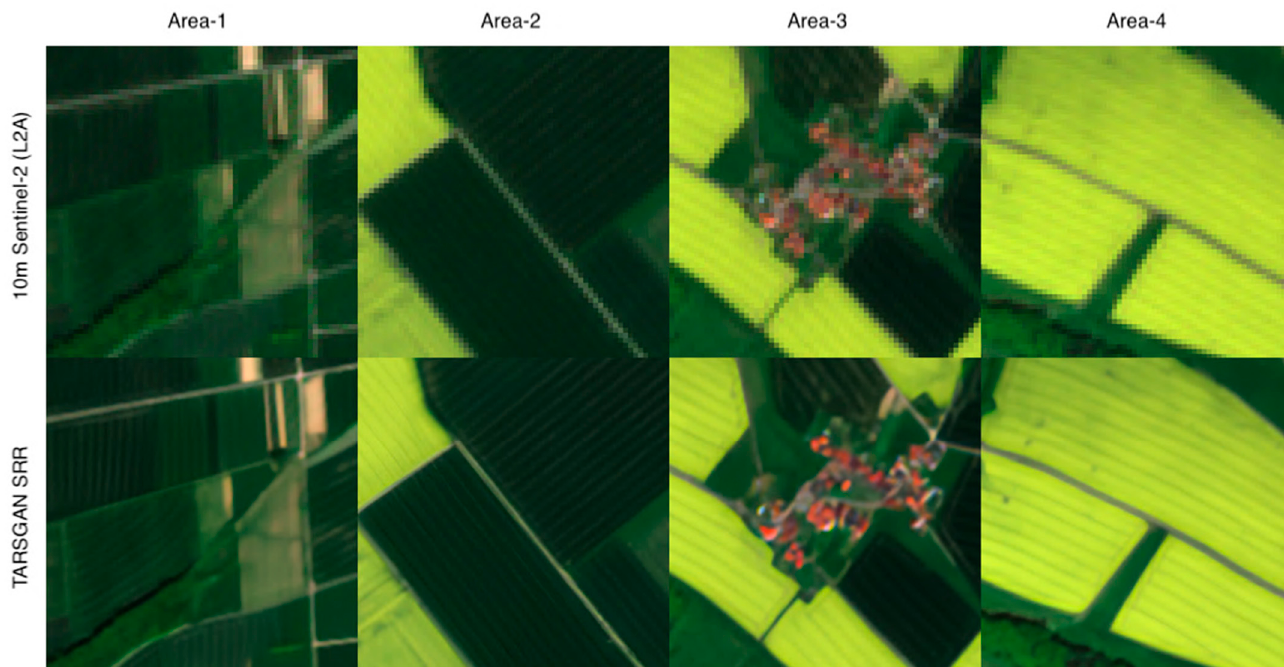
Figure 10. Cropped examples (625 m × 625 m) of the 10 m/pixel Sentinel-2 “true” colour images (L2A) and TARSGAN SRR result over Hainich, Germany (Site-3). Please refer to supplementary material for full-size SRR (produced from Sentinel-2